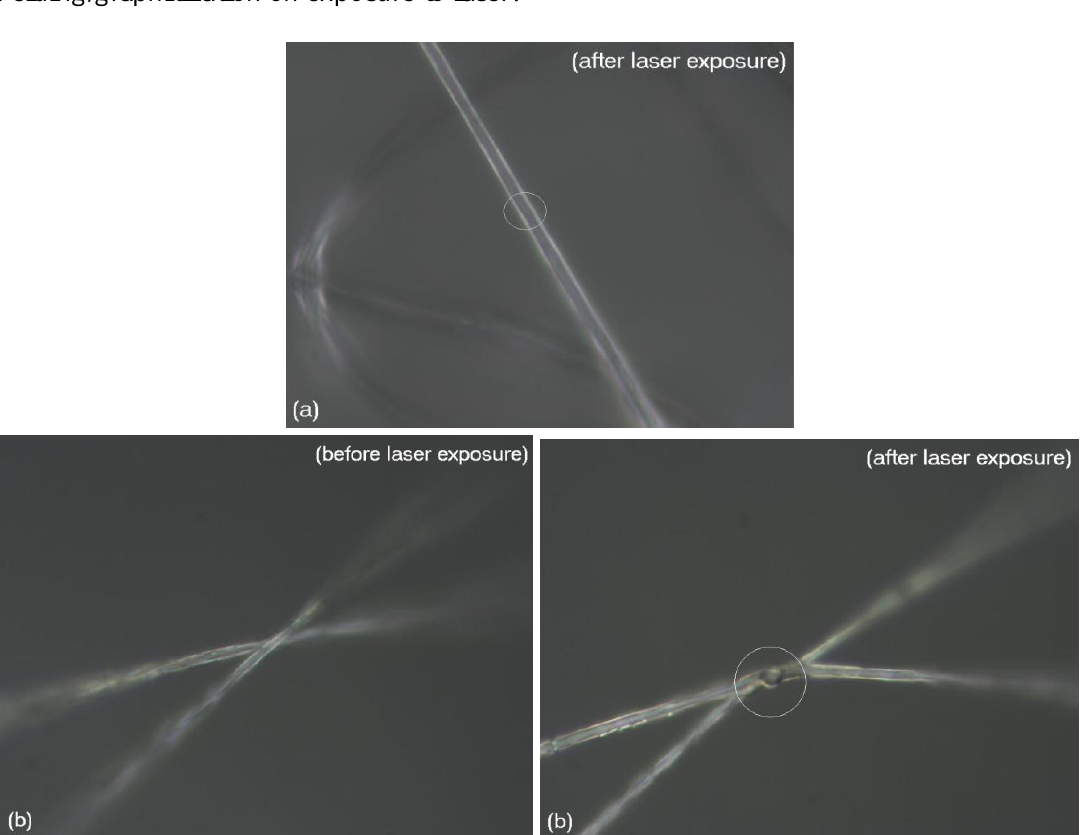
Figure 3. Effect of 532 nm, 20 mW laser on fibers. ( a ) Uncoated fibers showed no melting on exposure to laser (encircled area); ( b ) Fibers coated with 2 nm Ag showed welding/graphitization on exposure to laser.